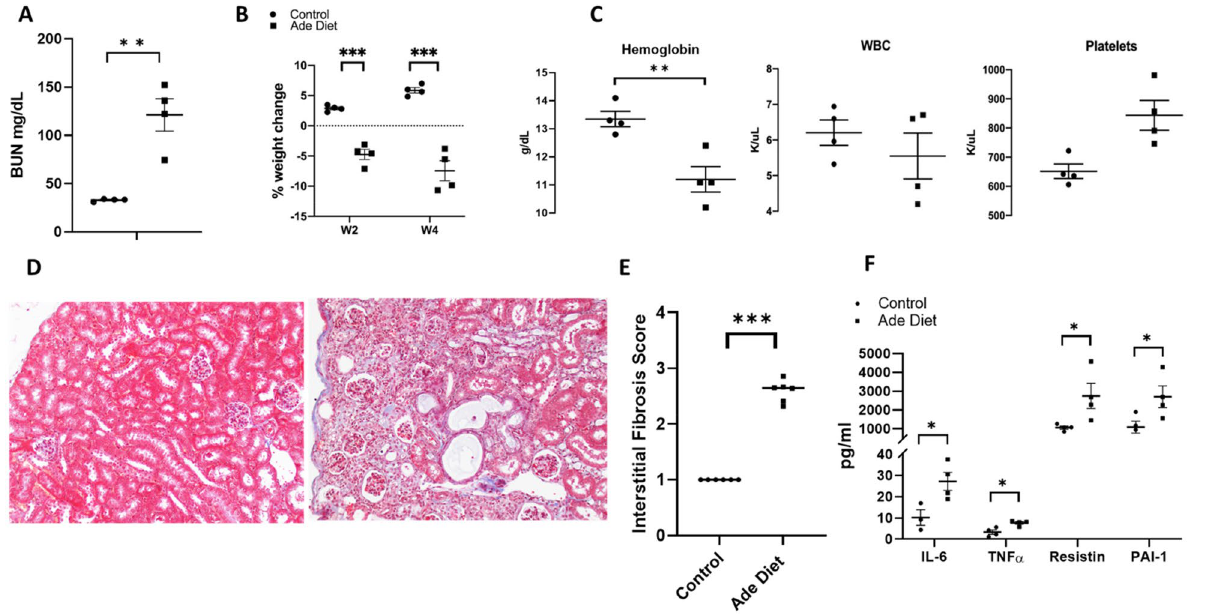
Figure 5. Phenotypic characteristics of adenine diet induced chronic kidney disease mice. ( A ) BUN level (mg/dL) in WT adenine diet fed mice versus control mice. ( B ) Difference in % of weight change at week 2 and week 4 of treatment between control and adenine diet treated mice. ( C ) Difference in hemoglobin (g/ dL), white blood cells (K/μL), and platelets (K/μL) between the control group and the adenine diet group. ( D ) Representative photographs of sections of Masson Trichrome stained renal tissue from 2 animals treated with control or adenine diet for 4 weeks. Left panel of control animal shows preserved tubules, whereas the right panel demonstrates atrophic tubules with inflammatory interstitial infiltrate, ( E ) Interstitial fibrosis score of control and adenine diet groups on Masson Trichrome stained sections. At least 10 fields per mice were used at 20× magnification. ( F ) Comparison of cytokine values between the control group and the adenine diet group. Unpaired t test, n = 4, error bars represent SEM *p ≤ 0.05, **p < 0.01, ***p < 0.001. BUN, blood urea nitrogen. WT, wild type. Ade, adenine diet. WBC, white blood cells. PLT,